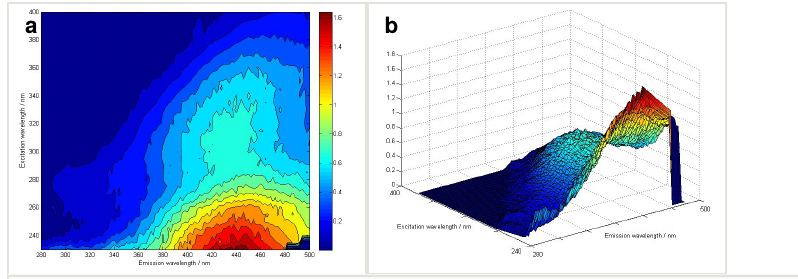
An example of a fl uorescence EEM “ fi ngerprint” of drinking water. Multivariate modelling of EEM datasets allows the most important areas of the EEM to be identi fi ed, and used for simpli fi ed online fl uorescence